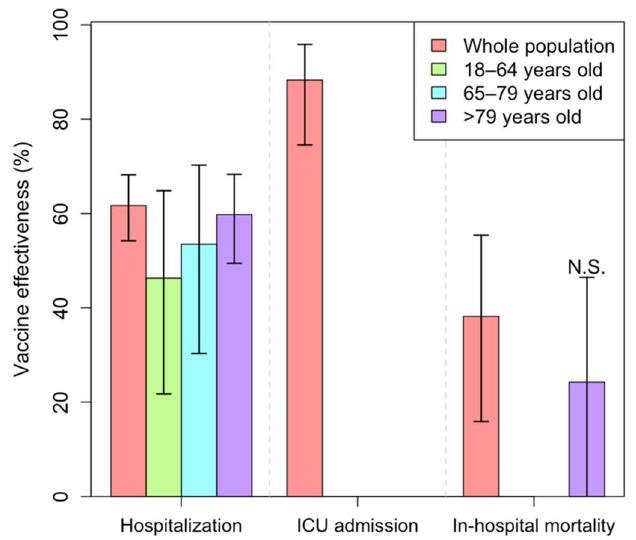
Figure 3. Vaccine’s effectiveness results ogBNT162b2 vaccine. 95% CI are displayed in black lines. Extended results in Table S2. N.S.: not significant.